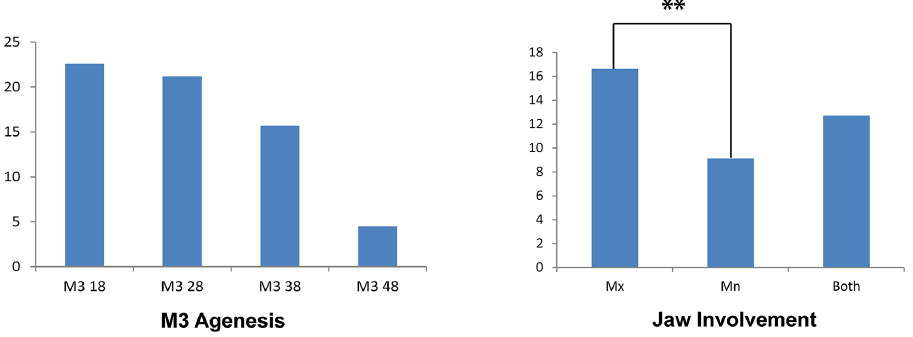
Fig 1. Distribution of subjects in total population with third molar agenesis and jaw